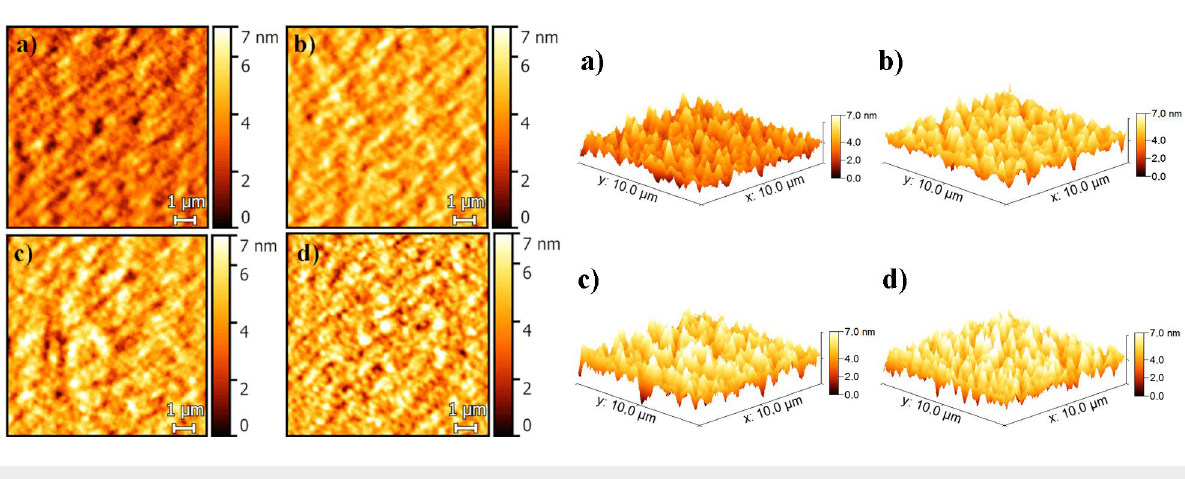
Figure 7: 2D (left) and 3D (right) AFM images of the OPVs with different concentrations of FeS 2 (a) 0.0 wt %, b) 0.25 wt %, c) 0.5 wt % and d) 1.0 wt %) recorded in noncontact mode.